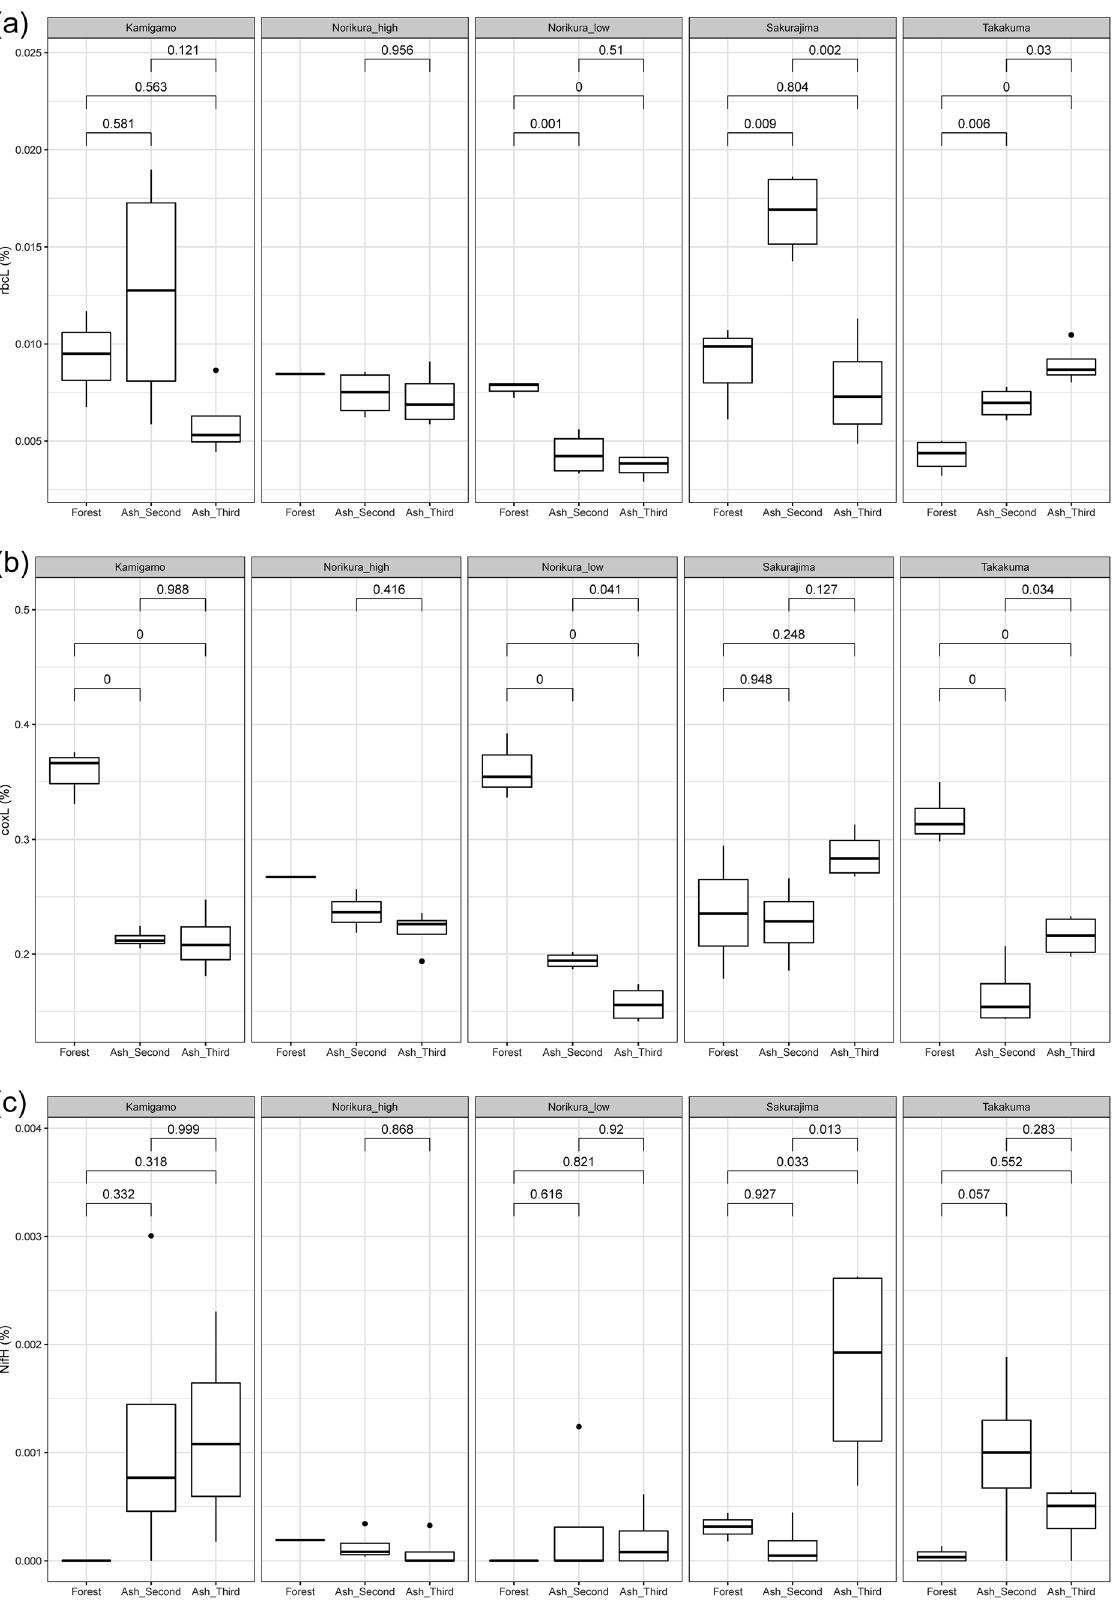
Figure 5. ( a ) Relative abundance of rbcL (ribulose bisphosphate carboxylase large chain) gene in the ash soils and forest soils. ( b ) Relative abundance of coxL (Carbon monoxide dehydrogenase large chain) gene in the ash soil and forest soil. ( c ) Relative abundance of nifH gene in the ash soil and forest